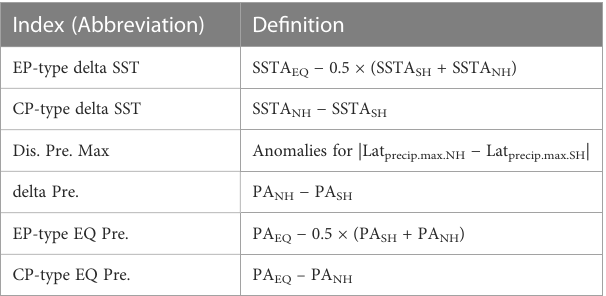
TABLE 1 The de fi nitions of indices used in this